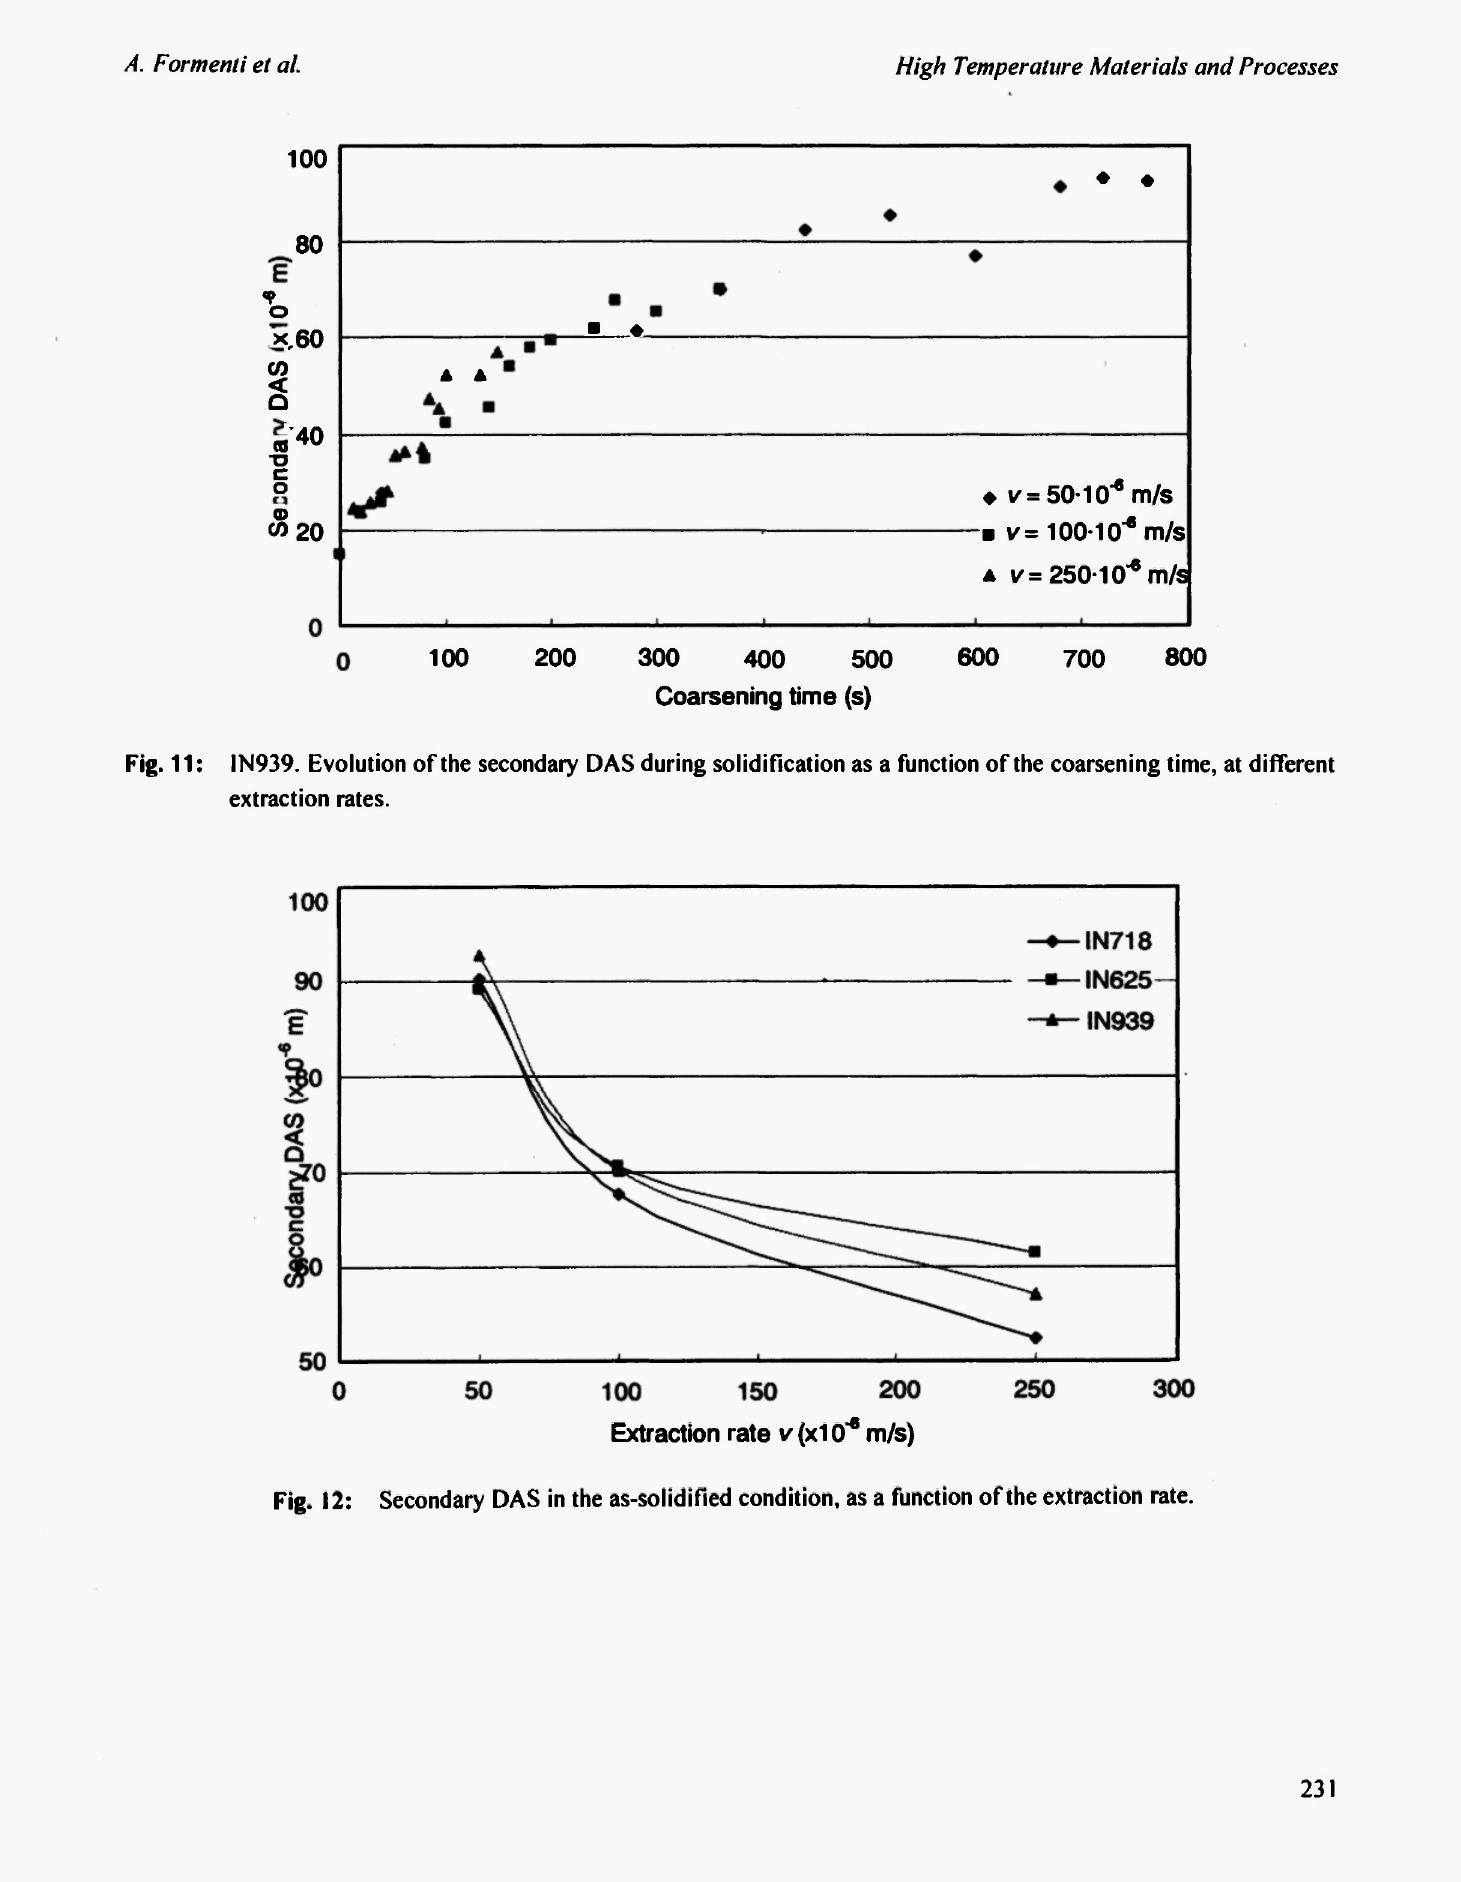
Fig. 12: Secondary DAS in the as-solidified condition, as a function of the extraction